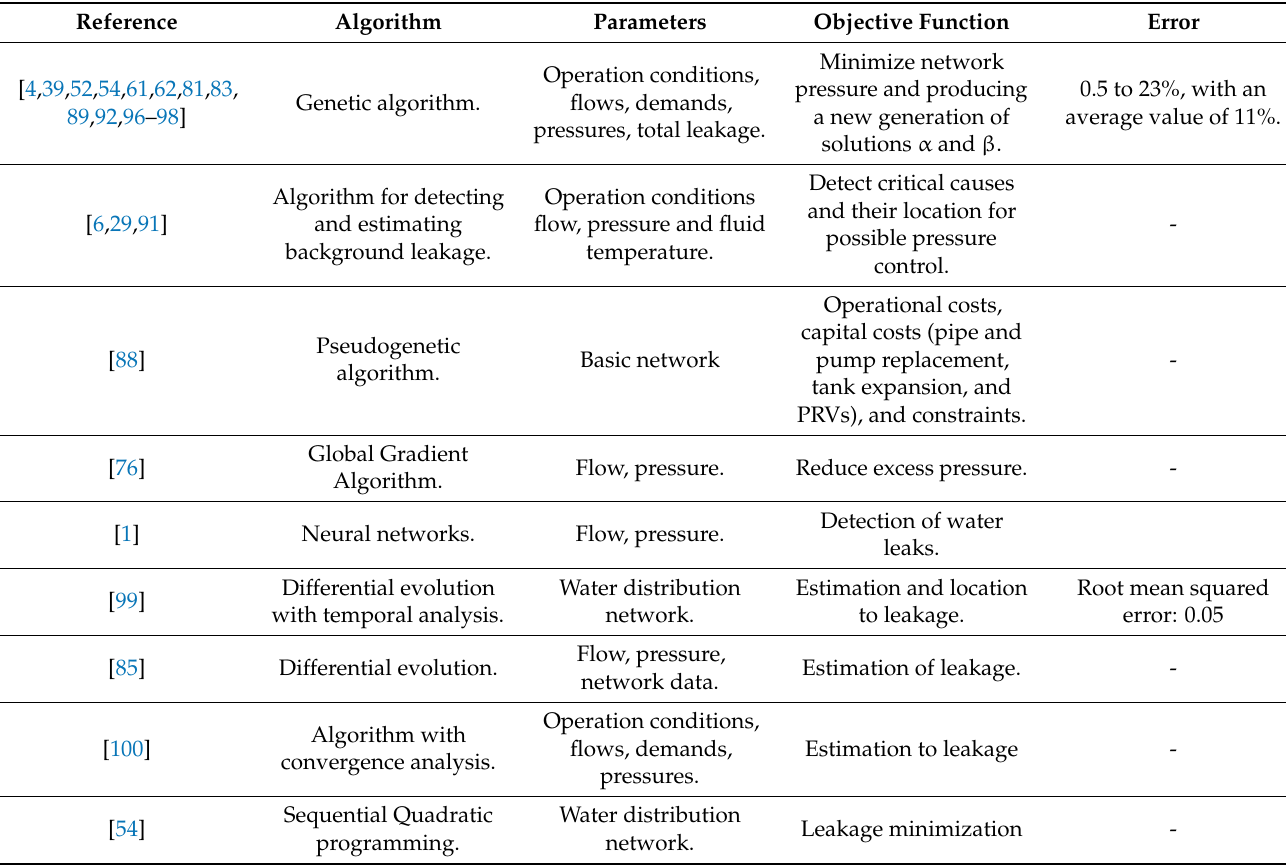
Table 5. Summary of optimization